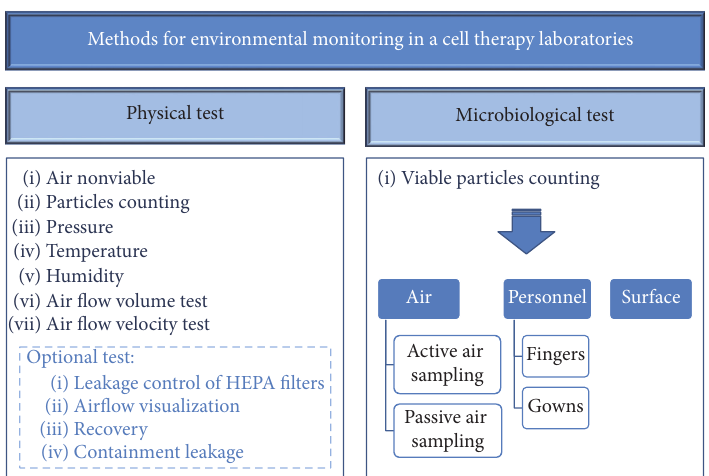
Figure 1: Scheme of environmental control requirements for the manufacture of SCMPs in cell therapy laboratories for the monitorization of viable and nonviable particles.